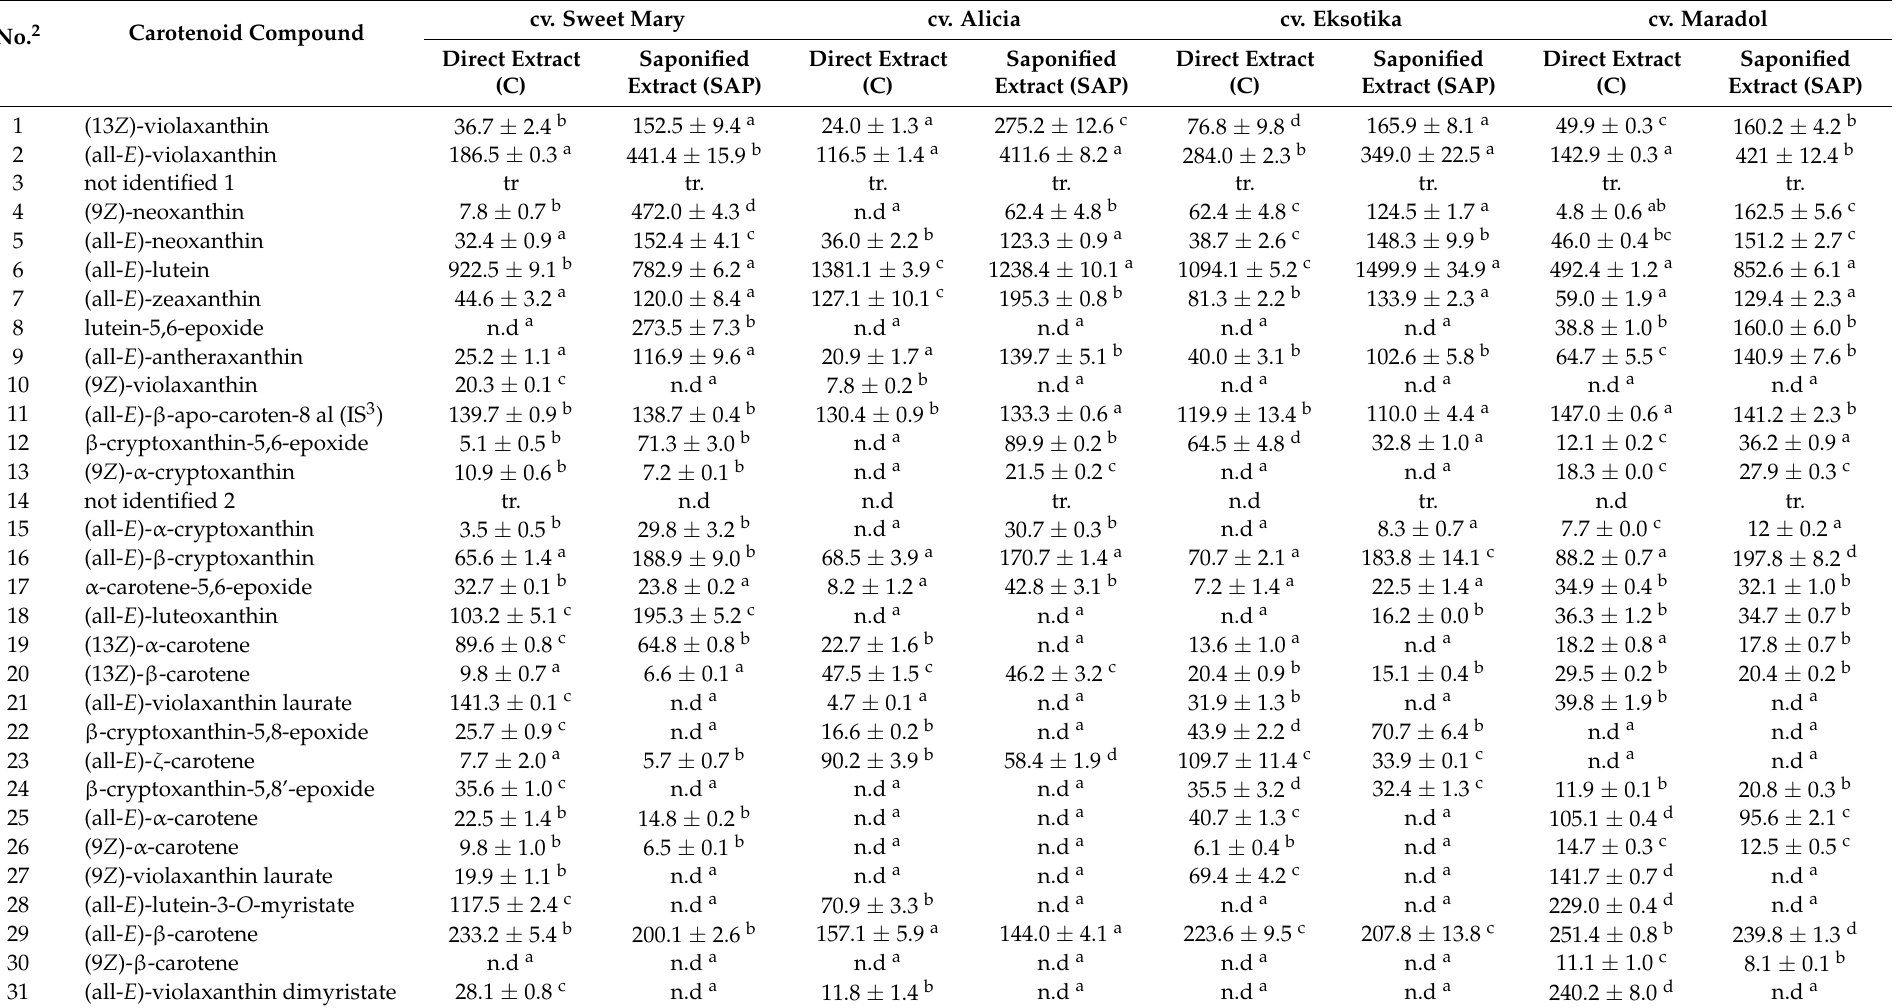
Table 4. Carotenoid content 1 ( µ g/100 g fresh weight ± standard deviation) and retinol activity equivalent (RAE) of direct and saponified extracts from papaya ( Carica papaya L.) peels of Sweet Mary, Alicia, Eksotika, and Maradol